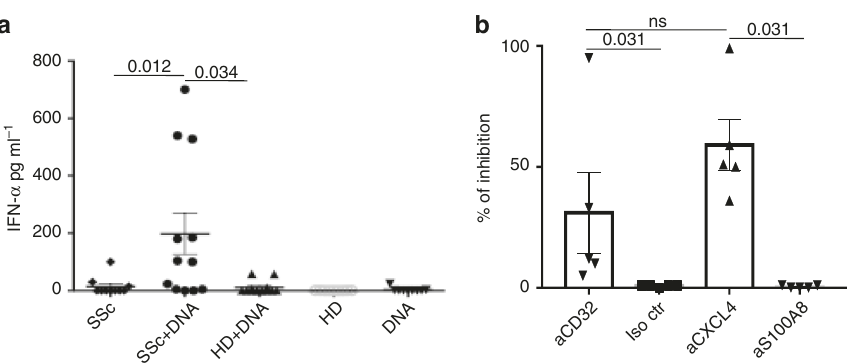
Fig. 7 CXCL4 from SSc blood stimulates pDCs in a DNA-dependent manner. a PDCs were stimulated with SSc plasma alone (SSc, 1:50 dilution) pretreated with 10 µ g ml − 1 of huDNA (SSc + DNA) or with plasma from HD (same dilution) also pretreated with huDNA (HD + DNA) or untreated (HD), or with huDNA alone (DNA). IFN- α was quantitated by ELISA after 24 h. Horizontal bars are the means, vertical bars are the s.e.m. P -values by Wilcoxon signed- rank test. b PDCs were treated with SSc plasma pretreated with huDNA as in a in the absence or in the presence of a neutralizing anti-CXCL4 antibody (aCXCL4; see Methods), neutralizing anti-CD32 antibody (aCD32) 16 , corresponding control (Iso ctr), or irrelevant antibodies (aS100A8), and IFN- α was analyzed after 24 h by ELISA. Data are expressed as percent of inhibition of IFN- α production (using as a reference the amounts of IFN- α obtained after stimulation with SSc plasma pretreated with huDNA). Signi fi cance was assessed by Wilcoxon